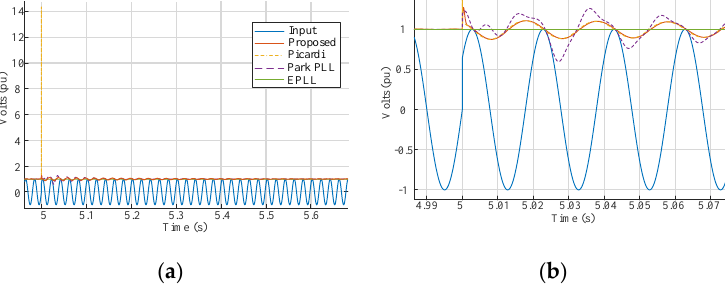
Figure 17. Comparison of amplitude detection techniques for a 40° phase jump for a 1 pu (50 Hz) input for ( a ) extended frame; ( b ) zoomed frame (same legend).